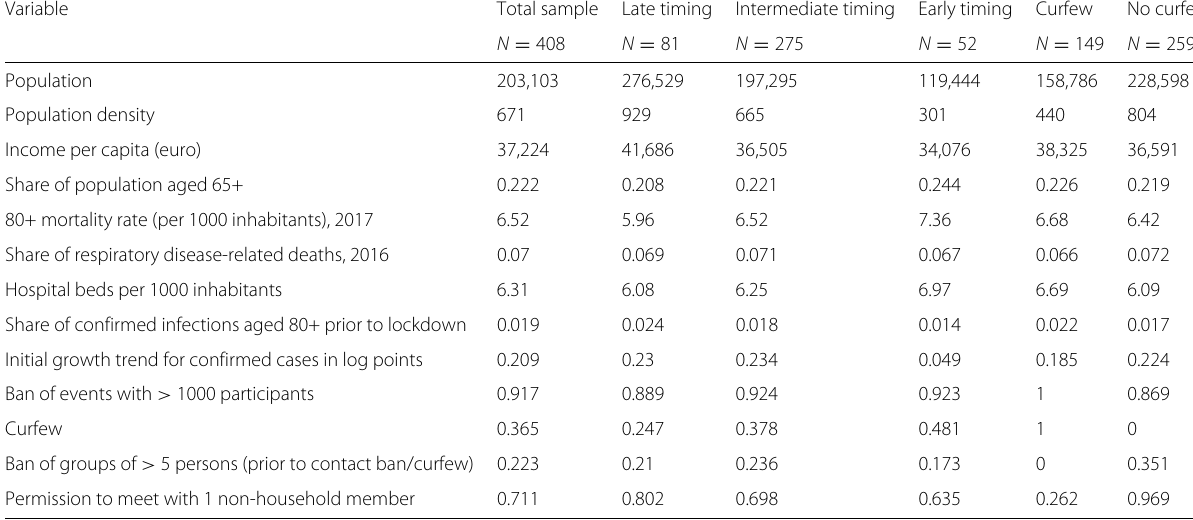
Table 2 Mean of covariates considered in the estimations using the German data in the total sample, the late intervention group, the intermediate intervention group, and the early intervention group, respectively